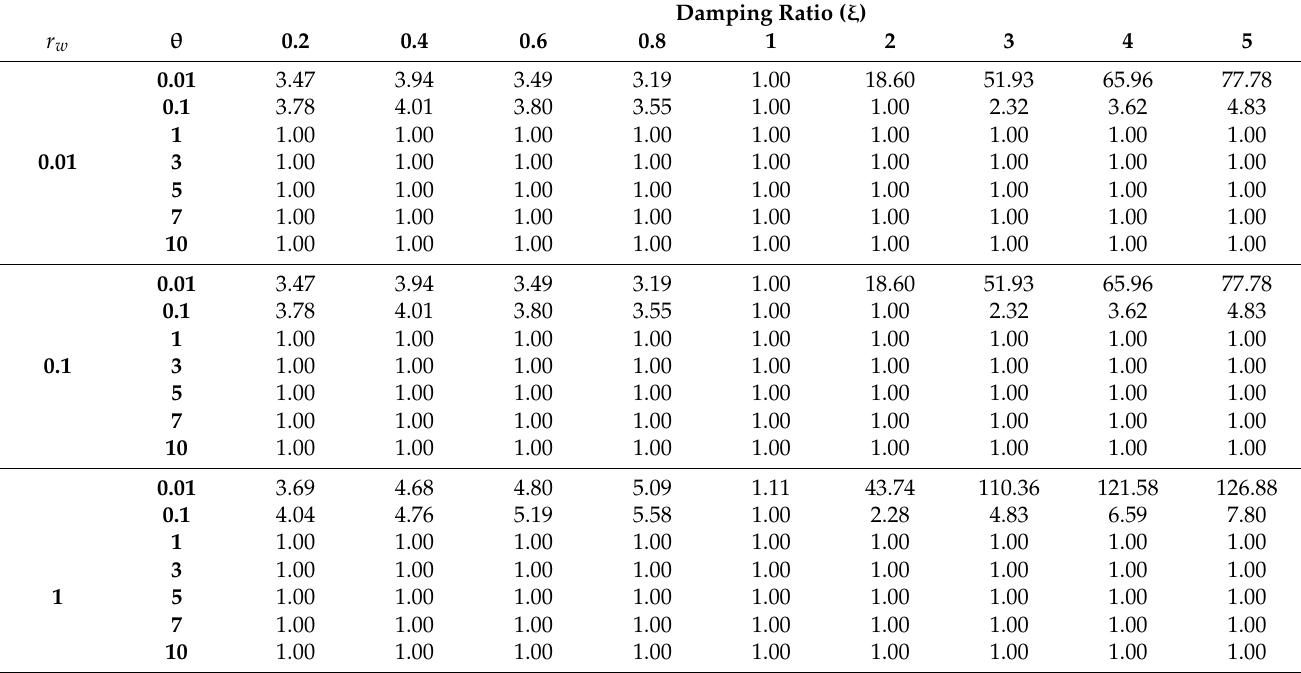
Table 10. Normalized IAE for MPC (Process 3, Disturbance